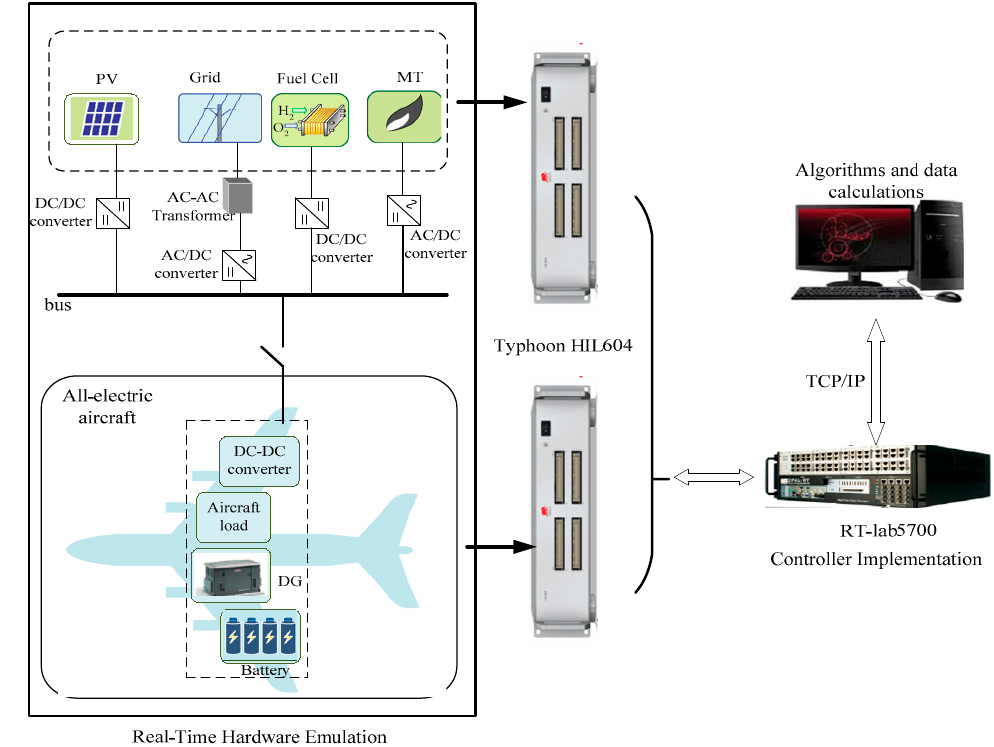
Figure 21. The hard-in-loop test bench for the airport microgrid management system.